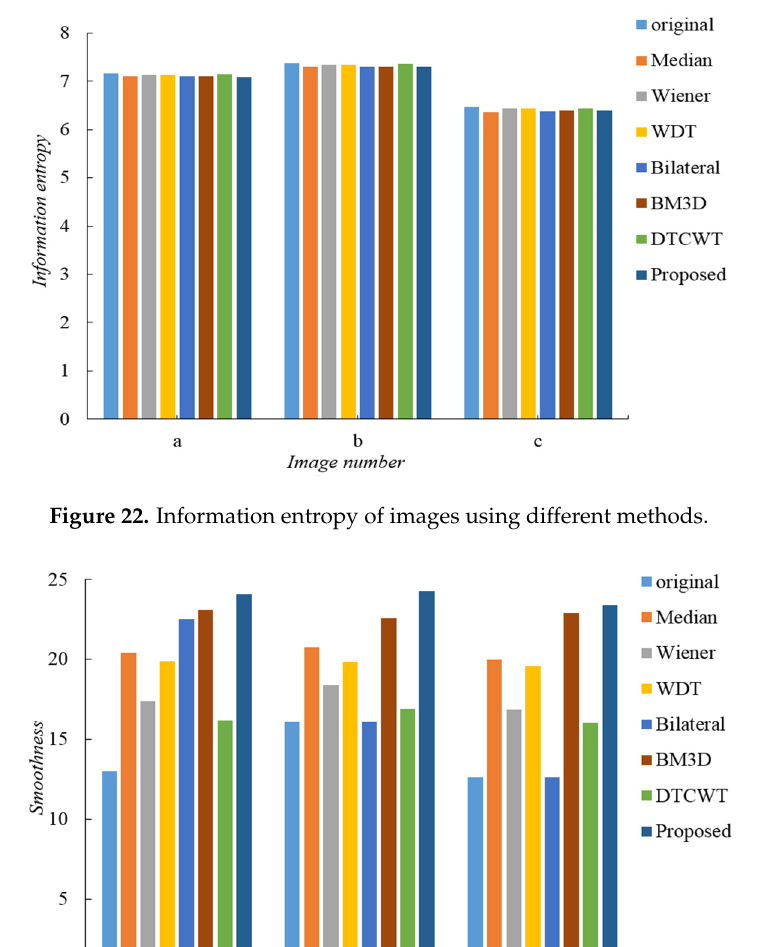
22 of 25 Figure 21. Original images and denoised images using different methods. (A) Infrared thermal image of cutting unit from the side; (B) Infrared thermal image of cutting unit from close distance; (C) Infrared thermal image of cutting unit from the front. As the images were denoised, the processed images would have less information than before. Therefore, information entropy was used to represent the amount of information contained in the image: the greater the value of information entropy, the more information the image contains. As the noise in the images was wiped by denoising methods, the denoised images were smoother than before. The information entropy ( Ie ) and smoothness ( Smo ) were introduced to evaluate the images in Figure 21, which could be calculated as